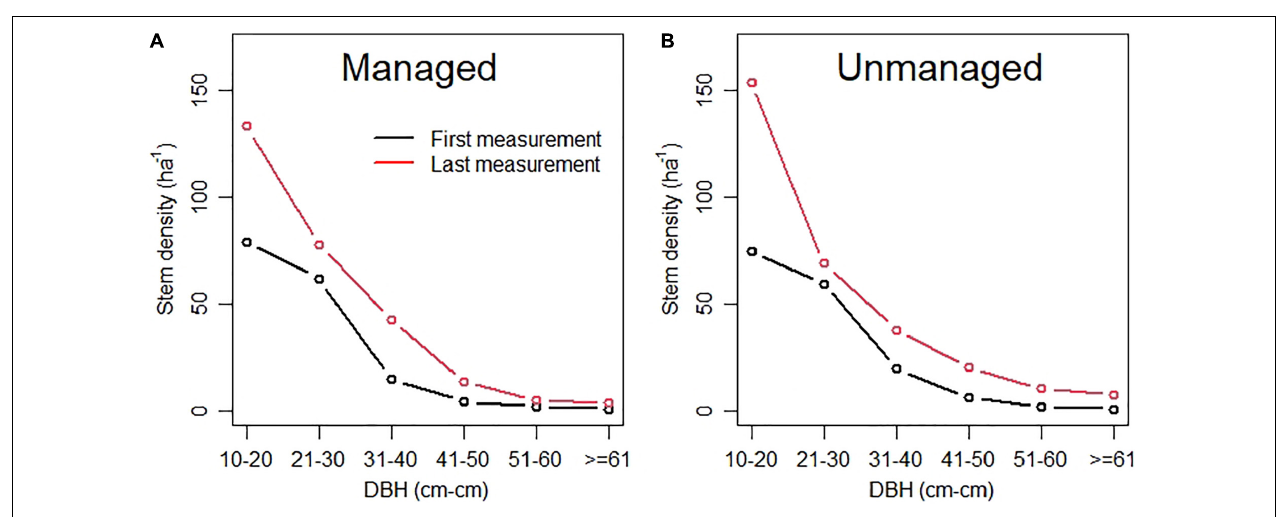
FIGURE 6 | Basal area increment (A,B) and recruitment (C,D) at the time of first and last measurements for managed (M) and unmanaged (UM) plots. For details see Figure 4 . In (C,D) , we used red dots to highlight the means.